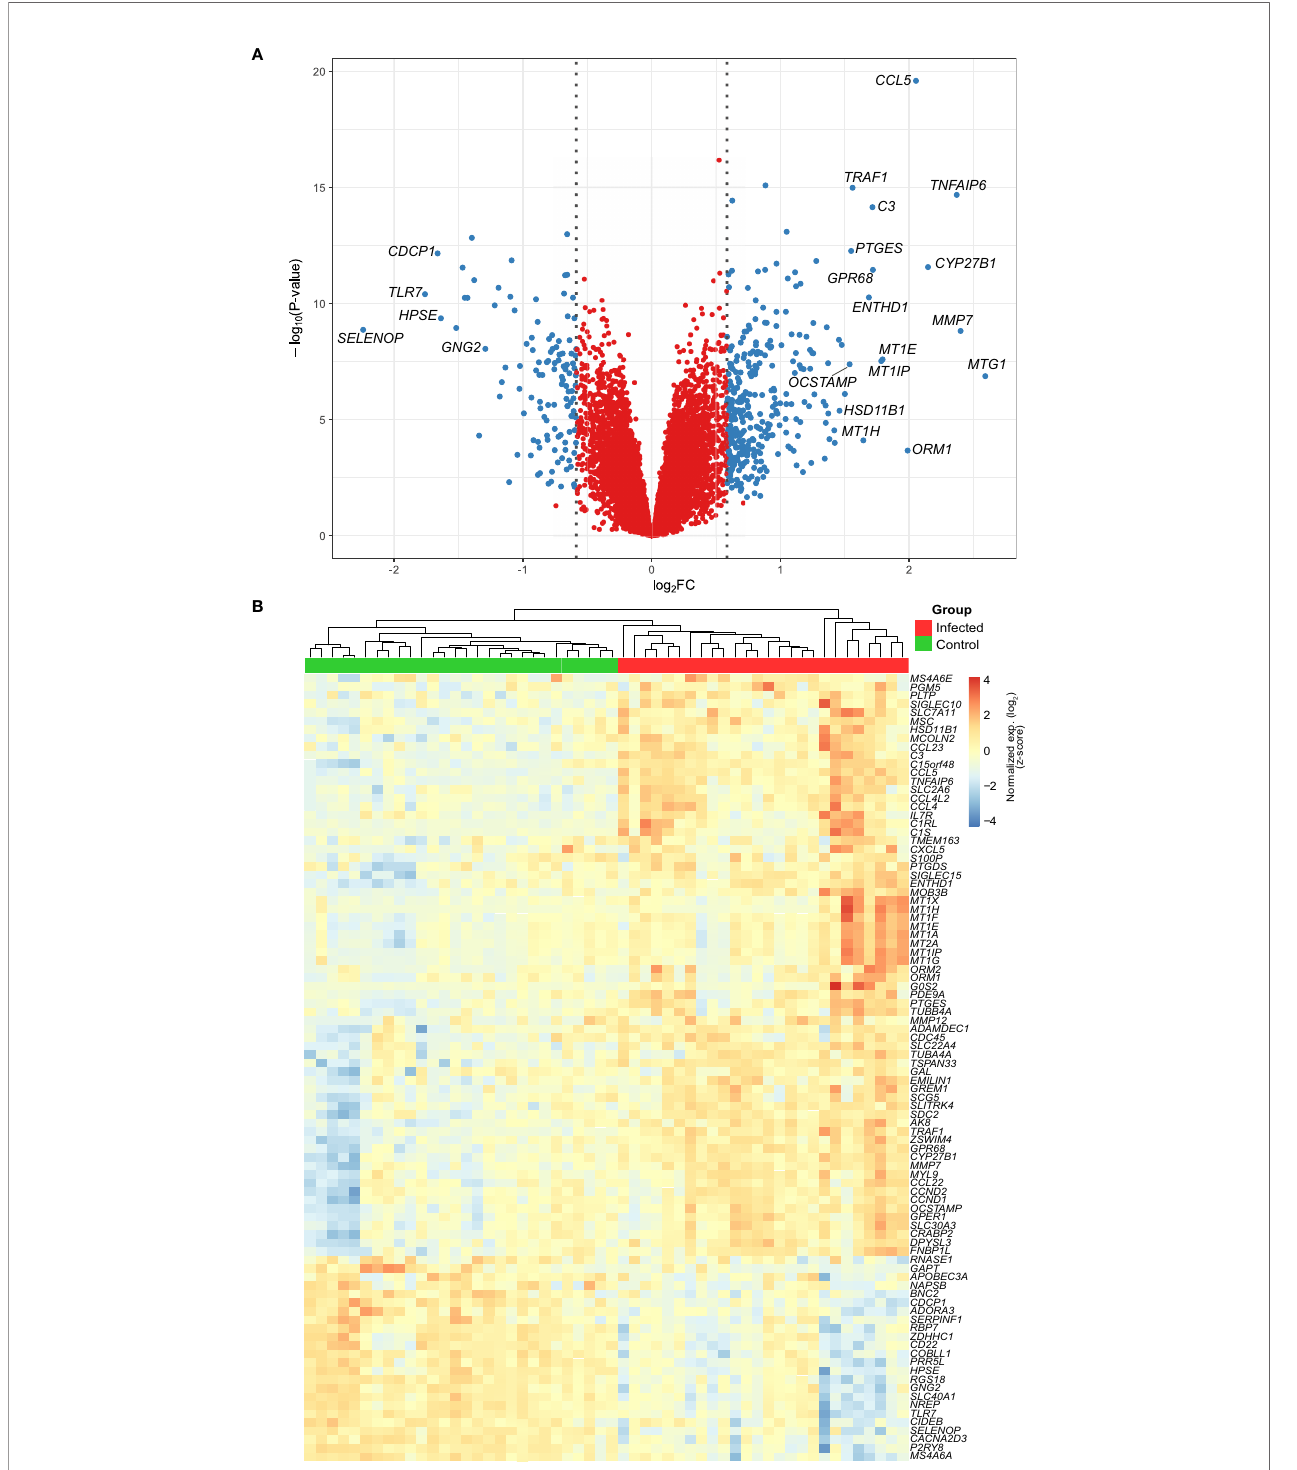
FIGURE 1 | (A) Volcano plot showing the DEGs from monocyte-derived macrophages infected with live M. leprae (MOI 10:1) for 48 h. Blue dots represent genes with an FDR ≤ 10% and |log 2 FC| ≥ 0.58. Gene symbols are given for those with an FDR ≤ 10% and |log 2 FC| ≥ 1.5. (B) Heatmap and unsupervised hierarchical clustering of genes with an FDR ≤ 10% and |log 2 FC| ≥ 1 (n = 92). Samples were clustered based on Euclidean distance and genes with Pearson correlation coef fi cient, both with average agglomeration. Color key displays expression values in standard deviation units away from the mean (i.e., scaled and centered row- wise). FDR, false discovery rate; FC, fold